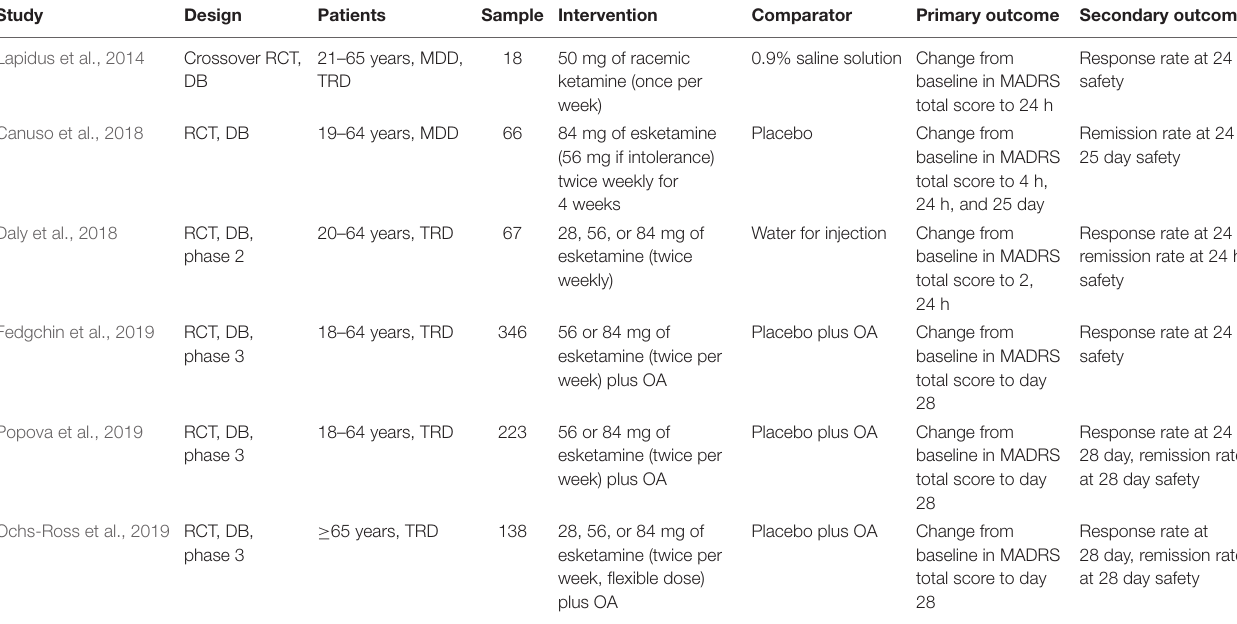
TABLE 1 | Characteristics of included